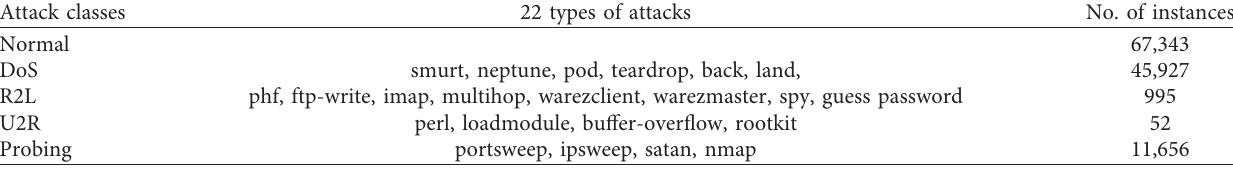
Table 8: NSL-KDD dataset.